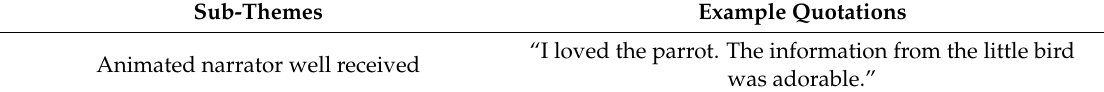
Table 2. Qualitative findings from patient pre-testing of Project BETTER’s novel technology-delivered intervention ( N =